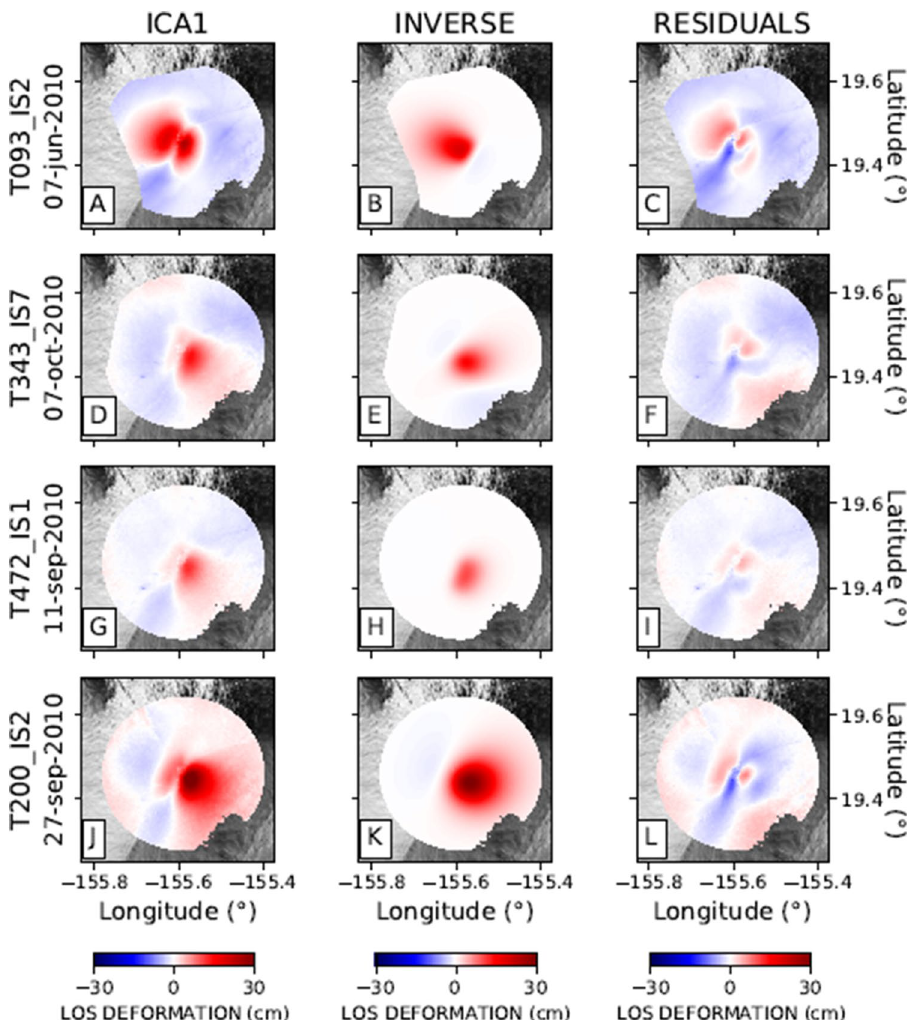
Figure 4. Inverse modelling of the Mauna Loa ground deformation source for four selected tracks: ( A ), ( B ), ( C ): ENVISAT 093 orbit; ( D ), ( E ), ( F ): ENVISAT 343 orbit; ( G ), ( H ), ( I ): ENVISAT 472 orbit; ( J ), ( K ), ( L ): ENVISAT 200 orbit, respectively. Column 1 represents the first component (ICA1) encompassing a radius of 20 km from Moku’āweoweo Crater. Column 2 represents the inverse model. Column 3 shows the